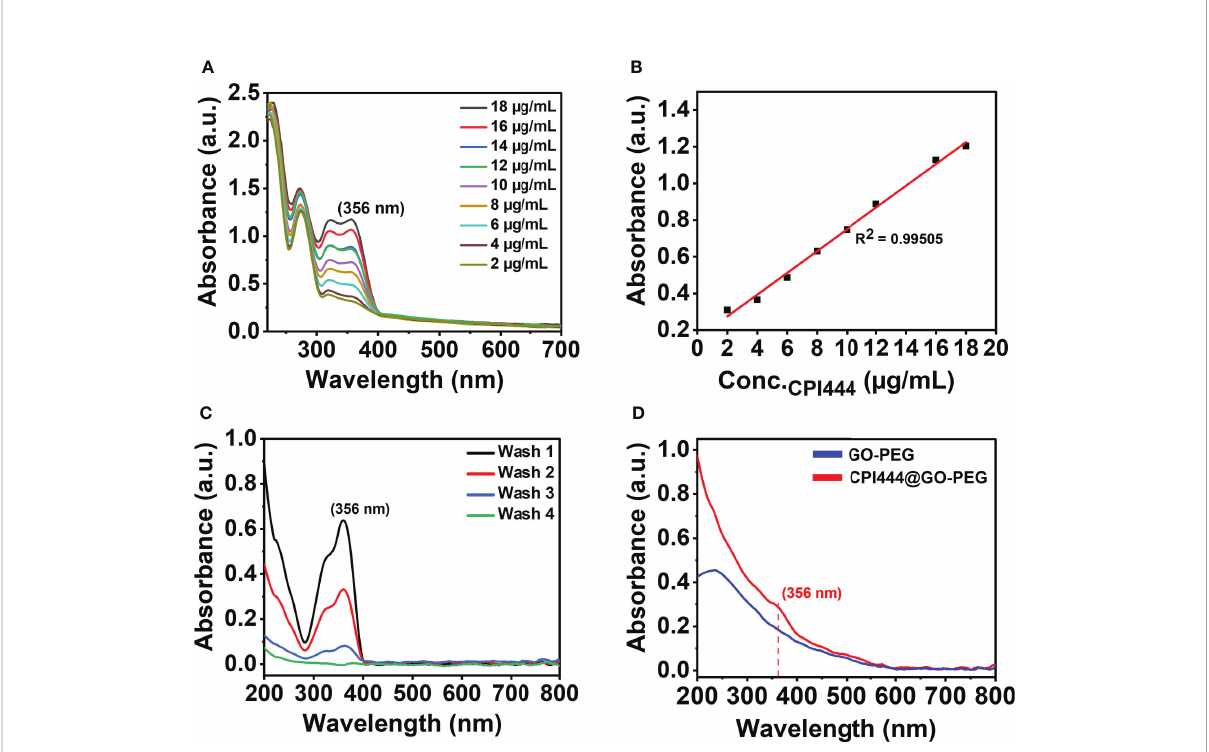
FIGURE 5 Quantitative and qualitative analysis for the formation of CPI@GO-PEG using UV – vis spectroscopy: (A) UV – vis spectra of CPI444 solution recorded at different concentrations in (water: THF) solvent mixture, (B) Linear equation obtained from the standard curve at a wavelength maximum of 356 nm, (C) UV – vis spectra recorded for unbound CPI444, (D) UV – vis spectra for GO-PEG and puri fi ed